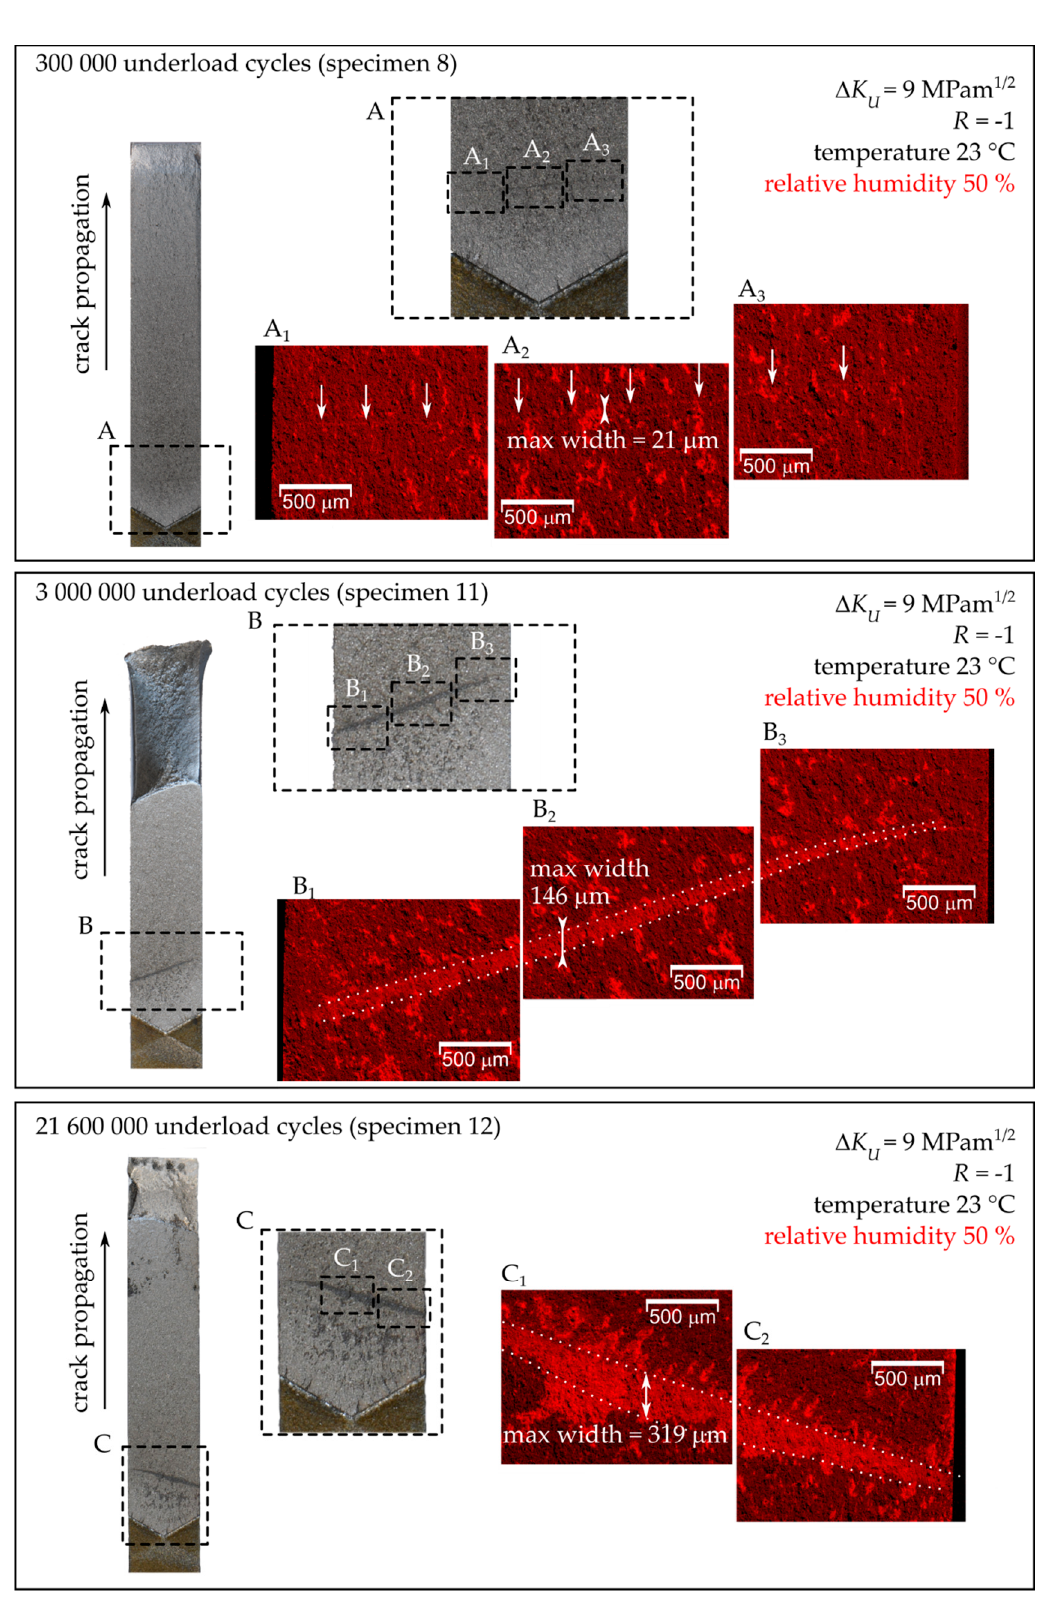
Figure 13. Fracture surfaces of Specimens 8, 11 and 12 tested in 50% relative humidity air (see also Table 3). On the left-hand side, the fracture surface of one quarter of the MT specimen with a detail is shown. The right-hand side shows the EDS maps of distribution of oxide particles.